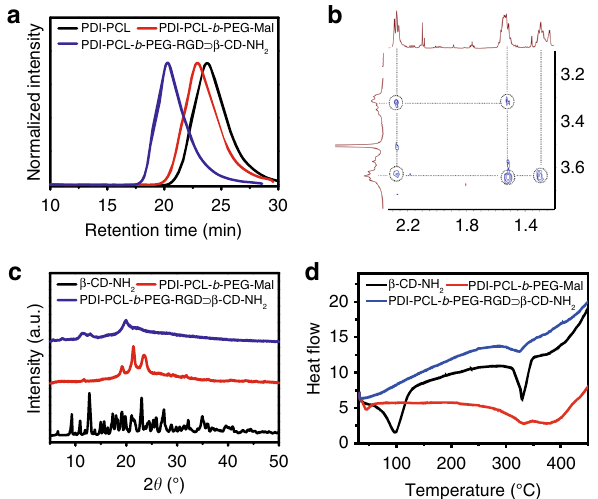
Fig. 2 Characterisation of polyrotaxane. a GPC curves of PDI-PCL, PDI-PCL- b -PEG-Mal, and PDI-PCL- b -PEG-RGD ⊃ β -CD-NH 2 . b 2D NOESY NMR spectrum (500 MHz, 298 K) of PDI-PCL- b -PEG-RGD ⊃ β -CD-NH 2 . c XRD patterns of β -CD-NH 2 , PDI-PCL- b -PEG-Mal, and PDI-PCL- b -PEG-RGD ⊃ β - CD-NH 2 . d DSC thermograms of β -CD-NH 2 , PDI-PCL- b -PEG-Mal, and PDI- PCL- b -PEG-RGD ⊃ β -CD-NH NH 2 cavities 17 . The X-ray diffraction pattern (XRD) of the freeze- dried PDI-PCL- b -PEG-RGD ⊃ β -CD-NH 2 was substantially dif- ferent from those of PDI-PCL- b -PEG-Mal and β -CD-NH 2 (Fig. 2c). XRD diffractograms of β -CD-NH 2 indicated a series of peaks ranging from 5° to 40°, con fi rming the macrocyclic structure 17 . PDI-PCL- b -PEG-Mal, a semicrystalline material with peaks at 22° and 24°, related to (110) and (200) lattice structures, respectively 18 . For PDI-PCL- b -PEG-RGD ⊃ β -CD-NH 2 , the most